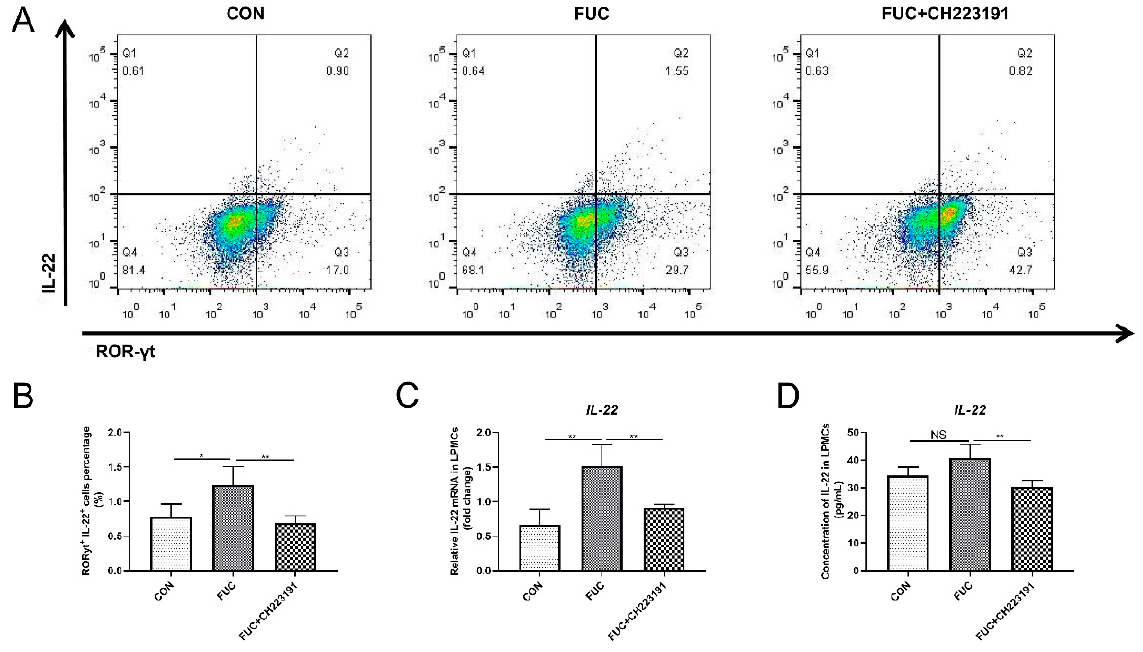
Figure 5. Increased IL-22 release from ILC3 cells through AHR activation after L-fucose treatment. ( A ) Representative flow cytometric profiles of IL-22 + ROR- γ t + cells in LPMCs. ( B ) Percentage of IL-22 + ROR- γ t + cells in LPMCs. ( C ) qRT-PCR analysis of IL-22 mRNA in LPMCs. ( D ) ELISA analysis of IL-22 in culture supernatant of LPMCs. Data are expressed as the mean ± SD. * p < 0.05, ** p < 0.01; NS, no significance.